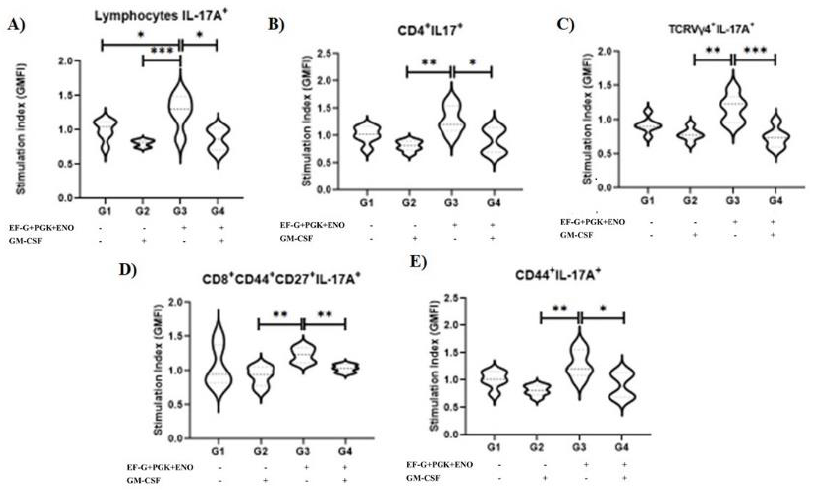
Figure 3. Geometric mean fluorescence intensity (GMFI) of IL-17A + production by T cells in mice vaccinated with three-antigens S. aureus -cure-associated recombinant proteins. T cell responses are normalized by dividing the GMFI of IL-17A + cells upon S. aureus stimulation per the percentage of IL-17A + cells under unstimulated control condition, thereby creating a stimulation index. Here, we show the GMFI of stimulation index of ( A ) overall lymphocytes, ( B ) T CD4 + , ( C ) TCRV γ 4 + and ( D ) T CD8 + CD44 + CD27 + (central memory) and ( E ) T CD44 + lymphocytes. Granulocyte-macrophage colony-stimulating factor; EF-G: elongation factor-G, ENO: enolase; and PGK: phosphoglycerate kinase. * indicate p ≤ 0.05, ** indicate p ≤ 0.01, *** indicate p ≤ 0.001 (One-way ANOVA followed by Tukey test).